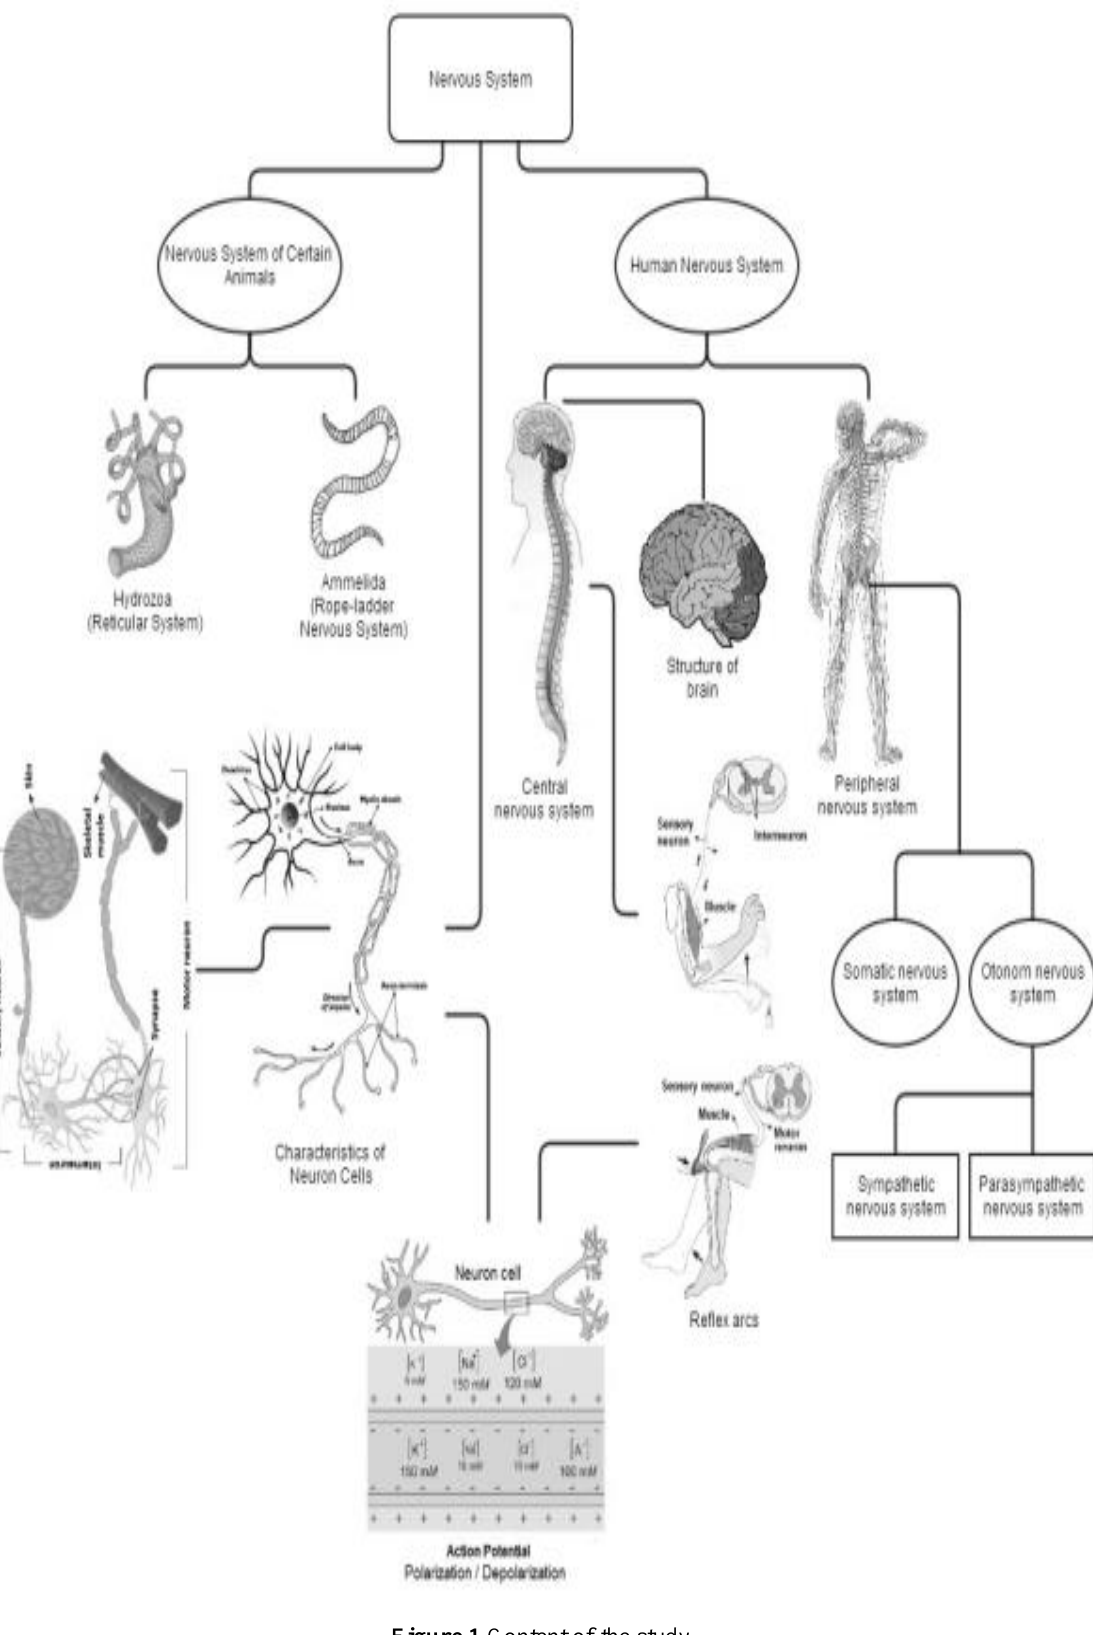
Figure 1 Content of the